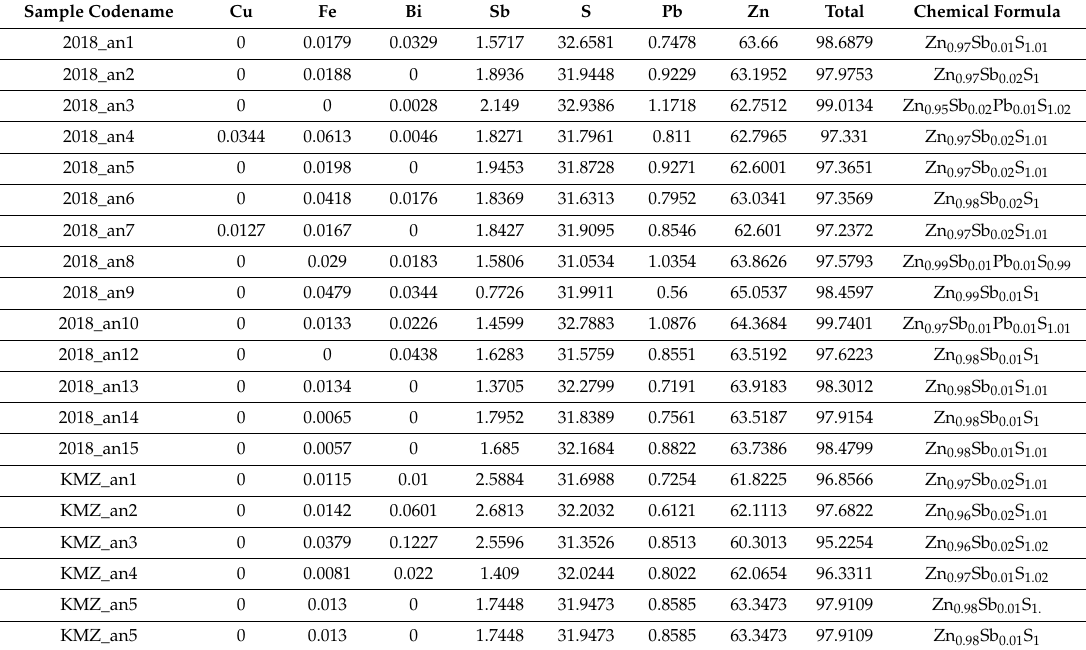
Table 2. Microprobe analysis results for colloform sphalerite.